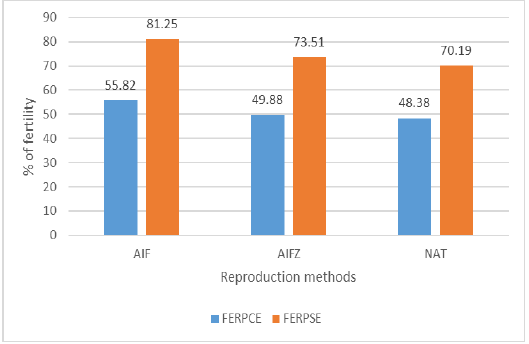
Figure 7. Variation of fertility according to the method of reproduction. FERPSE reached 81.25% when using AIF, 73.51% when using AIFZ, and 70.19% when using NAT.